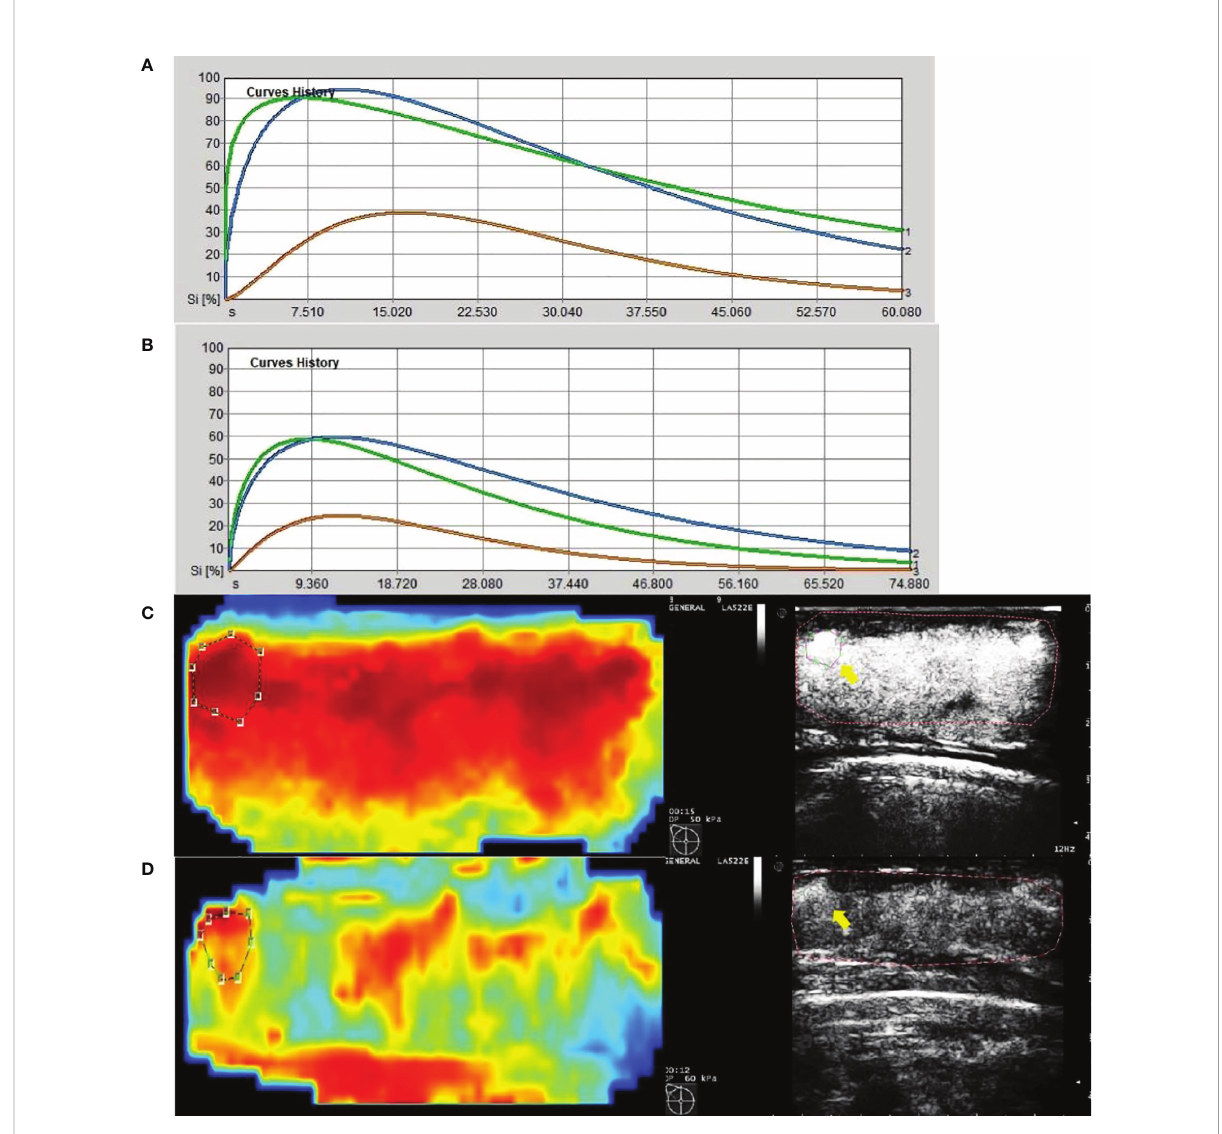
FIGURE 5 Images from a patient of response to NAC. (A) At baseline before NAC, contrast-enhanced ultrasound imaging showed a time-intensity curve generated according to regions of interest. The green line represents ROI 1(the greatest enhancement area in central region of tumor), the blue line represents ROI 2(the greatest enhancement area in edge of tumor), the yellow line represents normal breast tissue. (B) After the fi rst cycle of NAC, both ROI 1 and ROI 2 declined signi fi cantly. (C) At baseline before NAC, the circle represents ROI 2, and the red area means rich blood supply; the right image was gray-scale which correspond to the left one, and the yellow arrow referred to ROI 2. (D) After the fi rst cycle of NAC, the circle represents ROI 2, and the red area shrunk signi fi cantly; the right image was gray-scale which correspond to the left one, and the yellow arrow referred to ROI 2.